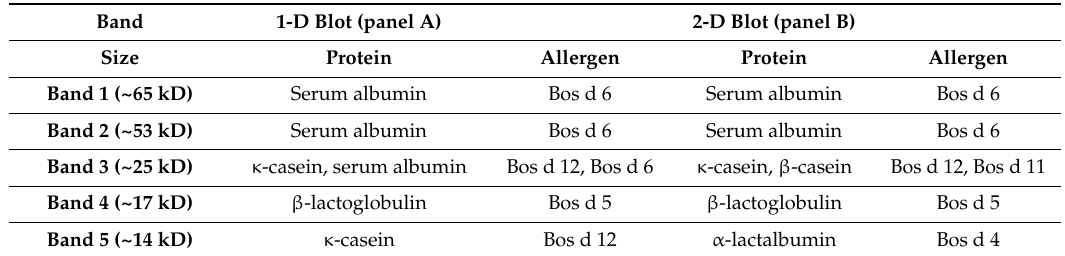
Table 3. Protein and allergen identification of IgE-reactive protein bands from western blot analysis of CM and CM-containing food